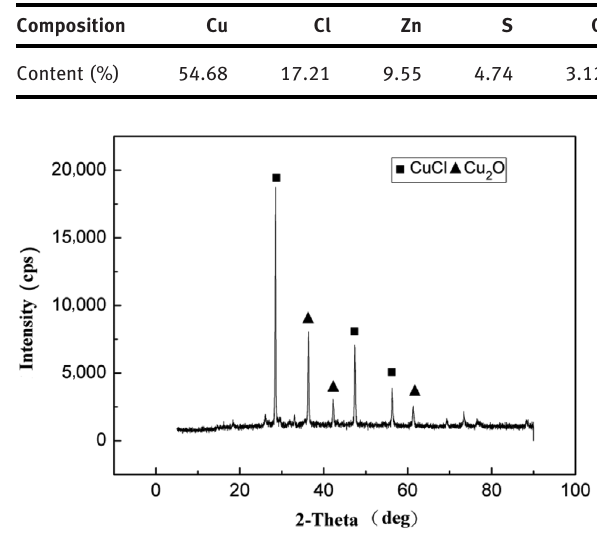
Figure 1: XRD patterns of the raw materials.